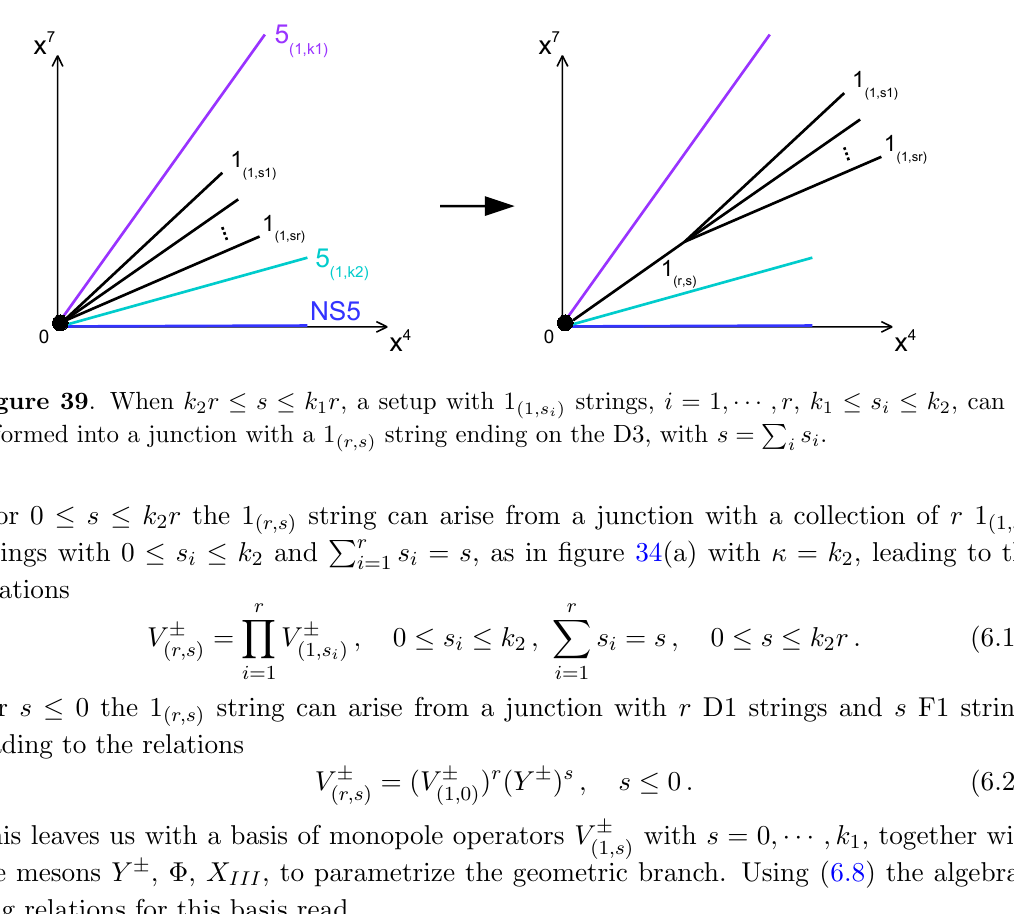
Figure 38 . (a) Brane setup with a semi-in(cid:12)nite 1 the relation V + V (cid:0) = ( X 1 ) j s (cid:0) k 1 r j ( X 2 ) j s j ( X 3 ) j s (cid:0) k 2 r j ( X 4 ) j s (cid:0) k 2 r j ( X 5 ) j s j . The vertical direction is ( r;s ) ( r;s ) that spanned by the 1 string in the plane x 47 . ( r;s )